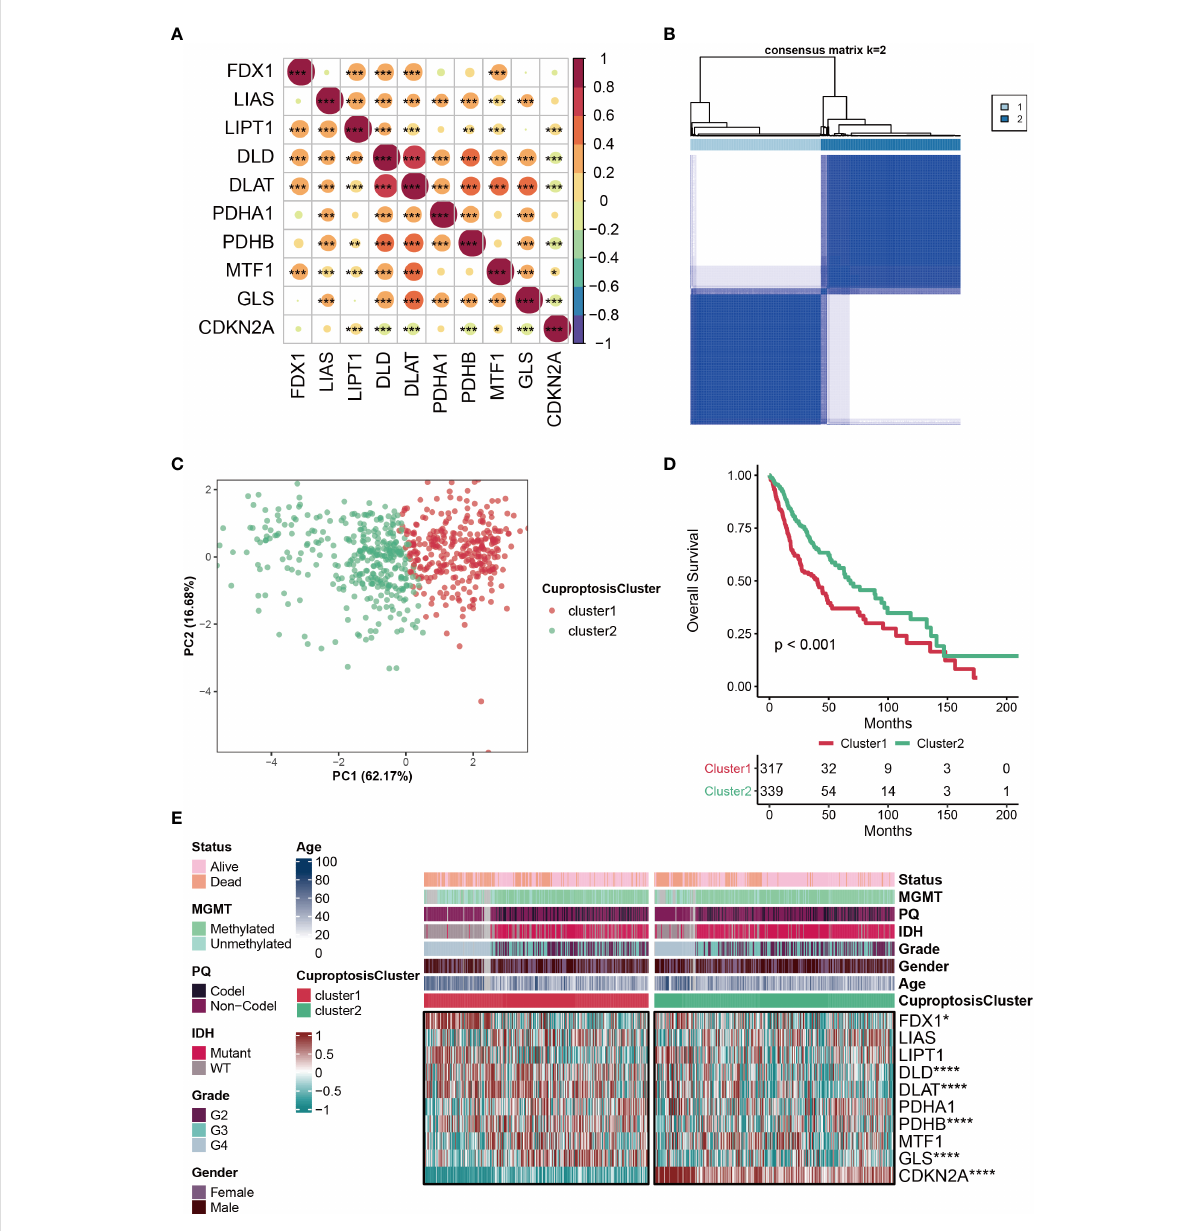
FIGURE 1 Characteristics of CuproptosisCluster in TCGA-glioma cohort. (A) The correlations among the ten cuproptosis-related genes (CRGs). The color represents the correlation coef fi cient. (B) Cluster diagram for subtype analysis of glioma samples. The intragroup correlations were the highest and the inter-group correlations were low when k=2. (C) PCA analysis for the two subclusters. (D) Kaplan-Meier survival curve showing survival probability of cluster1 and cluster2. (E) Heatmap showing the expression levels of the ten cuproptosis-related genes (CRGs) in different clinical features and clusters. *P < 0.05; **P < 0.01; ***P < 0.001; ****P <